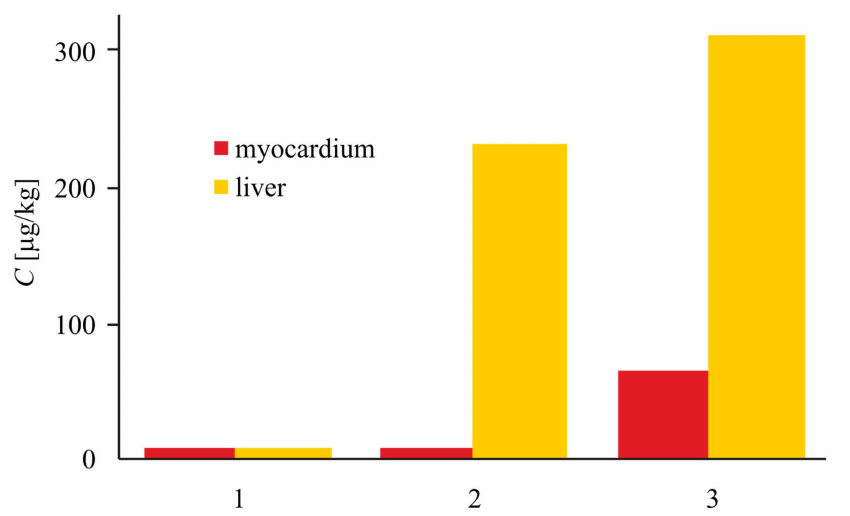
Figure 11. Silicon content ( C ) in the myocardium and liver of experimental animals of different groups, according to atomic absorption spectroscopy: 1, background levels; 2, sham operated animals, which underwent administration of silica nanoparticles; and 3, ischemia–reperfusion + silica nanoparticles (SNP) [12].